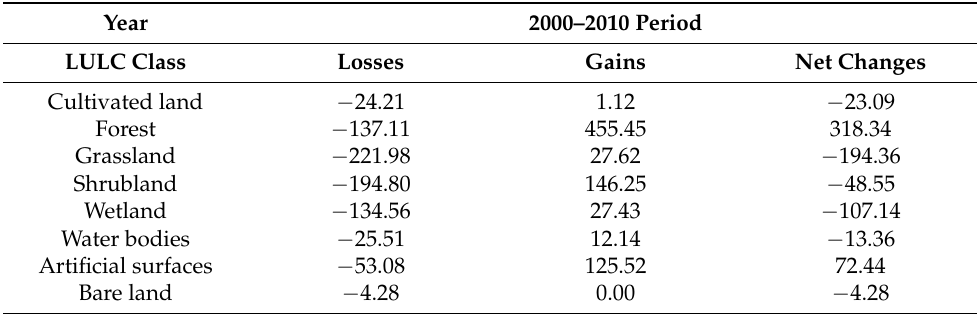
Table 5. Gains, losses, and net changes (km 2 ) in LULC from 2000 to